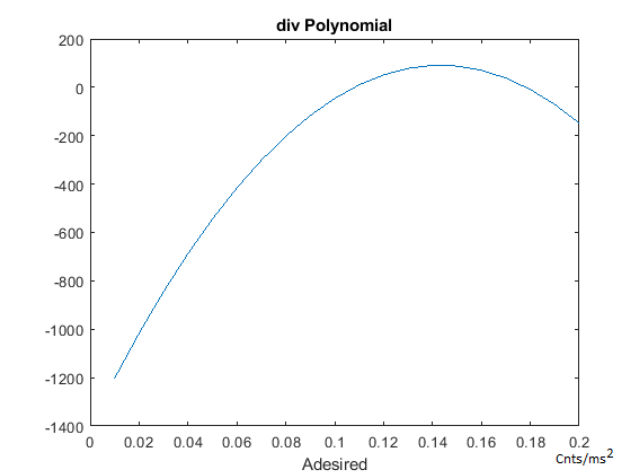
Figure 6. PID++ Vmax polynomial.